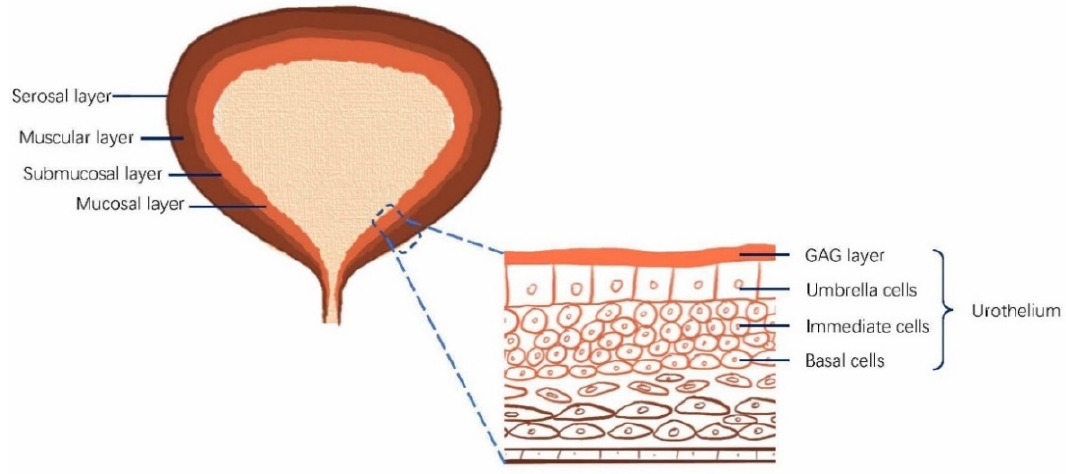
Figure 1. Bladder structure and the urothelium. The urinary bladder walls comprise four layers: the mucosa (urothelium), the submucosal layer, the muscular layer, and the serosal layer. The urothelium includes umbrella cells, intermediate cells, and basal cells. Glycosaminoglycan (GAG) is located at the urothelial luminal surface to form the negatively charged GAG layer, contributing to the bladder barrier function.